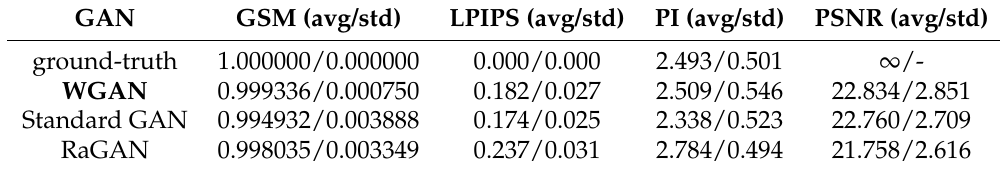
Table 3. The comparison of varied variants of